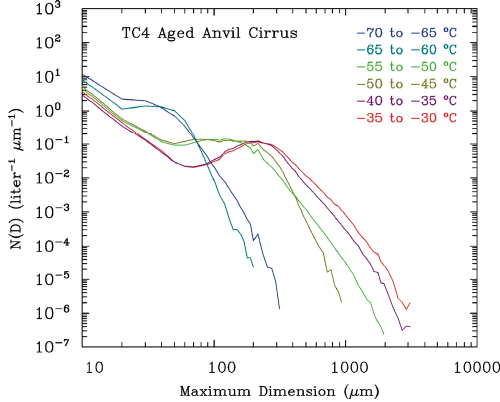
Figure 2. Temperature dependence of aged anvil PSD sampled during the TC4 field campaign.